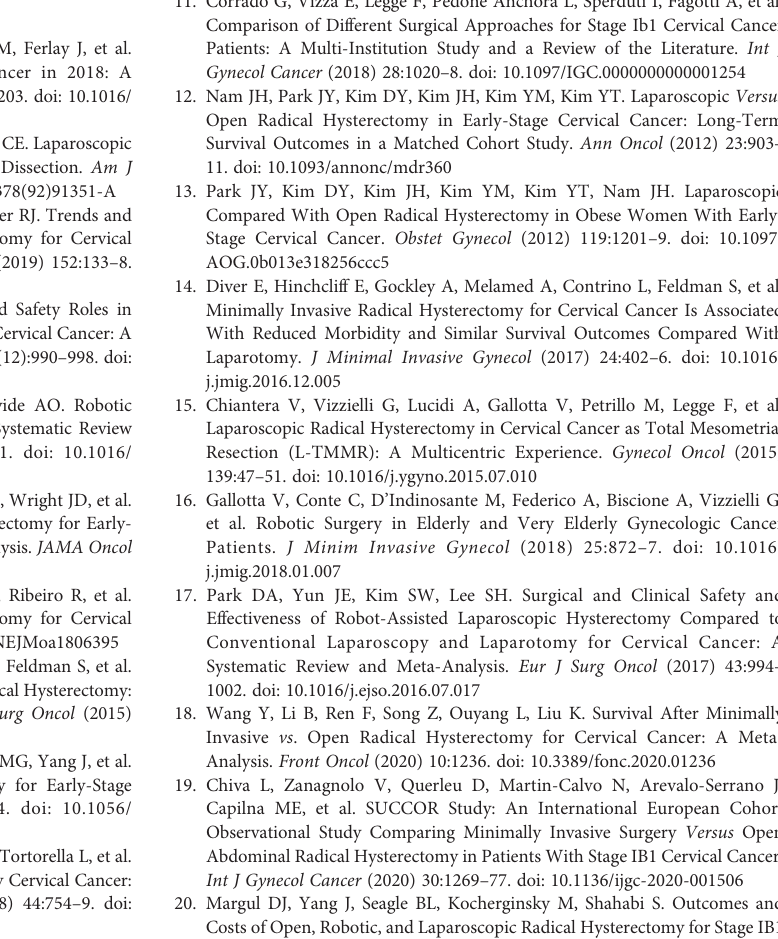
Supplementary Figure 2 | Survival and recurrence outcomes between open and laparoscopic radically hysterectomy for stage IA2, IB1, IB2 and IIA1 cervical cancer patients based on Federation International of Gynecology and Obstetrics (FIGO) 2018 staging system. (A) Overall survival (OS) curves of the patients before propensity score-based inverse probability of treatment weighting (PS-IPTW) analysis. (B) OS curves of the patients after IPTW analysis. (C) Progression free survival (PFS) curves of the patients before IPTW analysis. (D) PFS curves of the patients after IPTW analysis. Supplementary Figure 3 | Survival and recurrence outcomes between open and laparoscopic radically hysterectomy for stage IA2, IB1, IB2 and IIA1cervical cancer patients with no high and intermediate risks based on Federation International of Gynecology and Obstetrics (FIGO) 2018 staging system. (A) Overall survival (OS) curves of the patients before propensity score-based inverse probability of treatment weighting (PS-IPTW) analysis. (B) OS curves of the patients after IPTW analysis. (C) Progression free survival (PFS) curves of the patients before IPTW analysis. (D) PFS curves of the patients after IPTW analysis. Supplementary Figure 4 | Survival and recurrence outcomes between open and laparoscopic radically hysterectomy for stage IB3 and IIA2 cervical cancer patients based on Federation International of Gynecology and Obstetrics (FIGO) 2018 staging system. (A) Overall survival (OS) curves of the patients before propensity score-based inverse probability of treatment weighting (PS-IPTW) analysis. (B) OS curves ofthe patients after IPTW analysis. (C) Progression free survival (PFS)